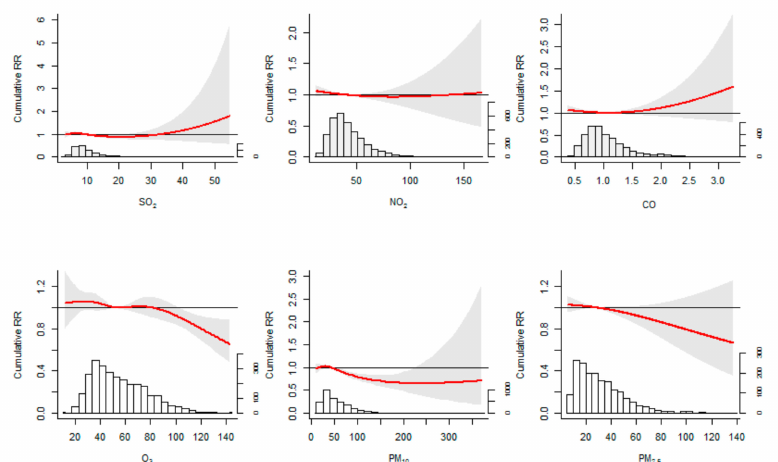
Figure 4. The estimated overall cumulative association between air pollutants and HFMD occurrence over 14 days with their distributions, using a natural cubic spline distributed lag nonlinear model adjusted by temperature and relative humidity. The red lines are the cumulative relative risks (medians as references), and the gray regions are 95% CIs. Shenzhen